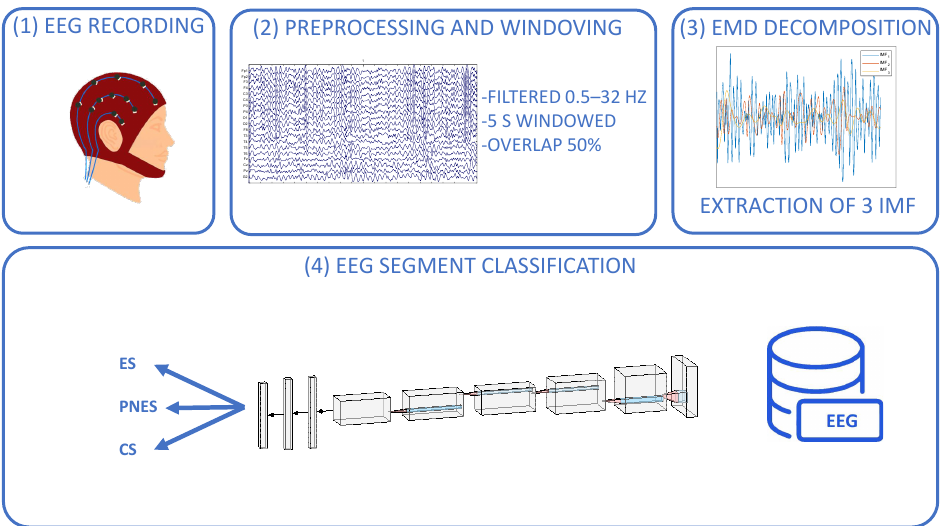
Figure 1. The electroencephalogram (EEG) was recorded and saved on a computer. Following that, the EEG was cleaned of artifacts, filtered, and divided into 50% overlapped EEG segments of 5 s each. Three IMFs of EMD over each channel were estimated for each EEG segment. The obtained database was the input of a convolutional neural network composed of two convolutional layers (+ReLu activation layer), two max pooling layers, three fully connected layers separated by a dropout layer, and a sigmoid layer that performs classification tasks (three ways: ES, PNES vs.